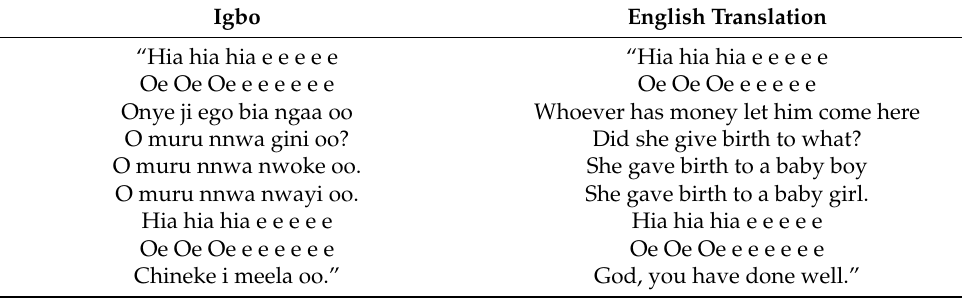
Table 2. Birth Song